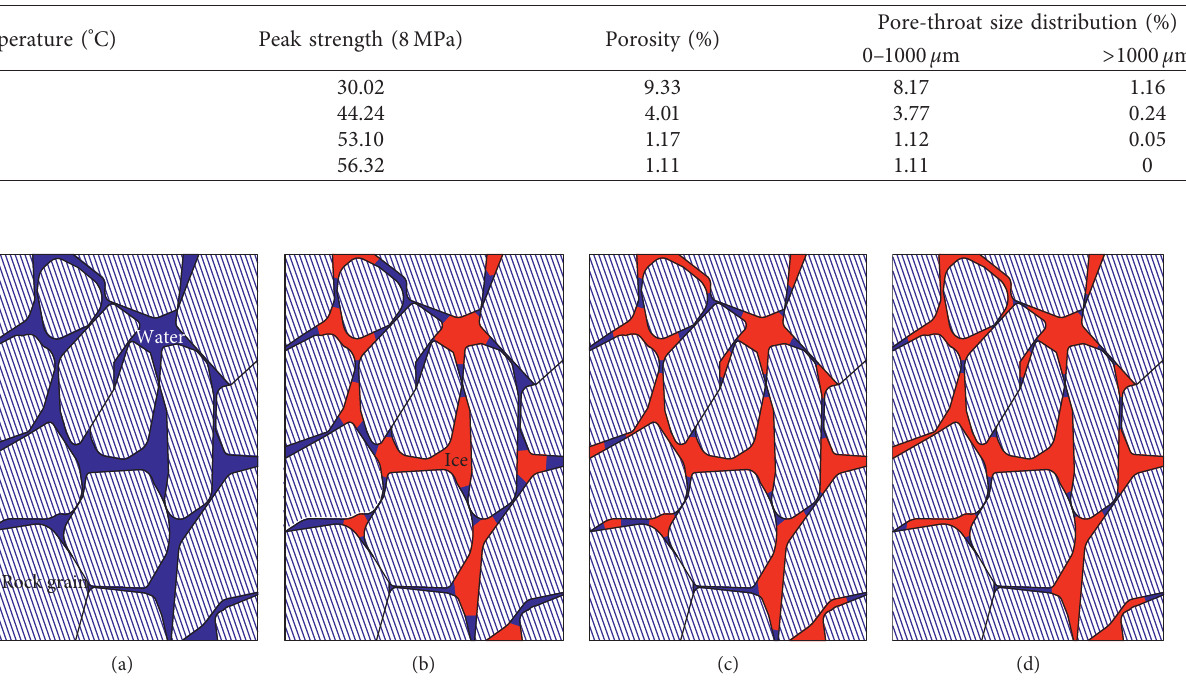
Figure 11: Formation process of pore (crack) ice during freezing: (a) 25 ° C, (b) − 5 ° C, (c) − 10 ° C, and (d) − 15 °